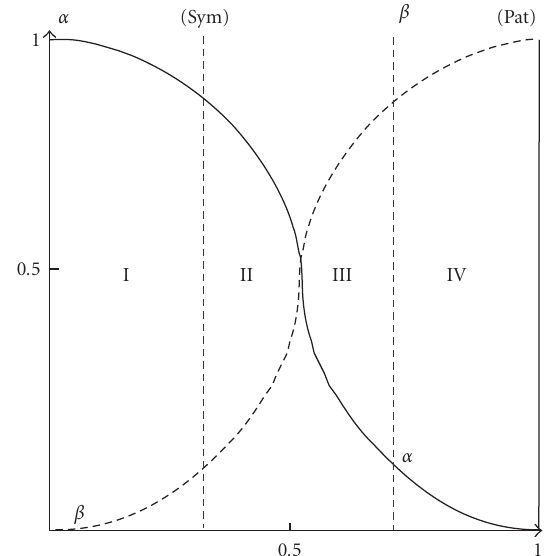
Figure 4: The duality relationship between Sym ( α i ) and Pat ( β i ). A cooperative relationship (NP-NS: health and mutualism) (I) occurs between the host and the NP microbial community. A competitive relationship (CP-CS) (II and III) exists between the host and the CP microbial community. There are two types of competitions: better (II) and worse (III). An antagonistic relationship (UP-US) (IV) oc- curs between the host and the UP microbial